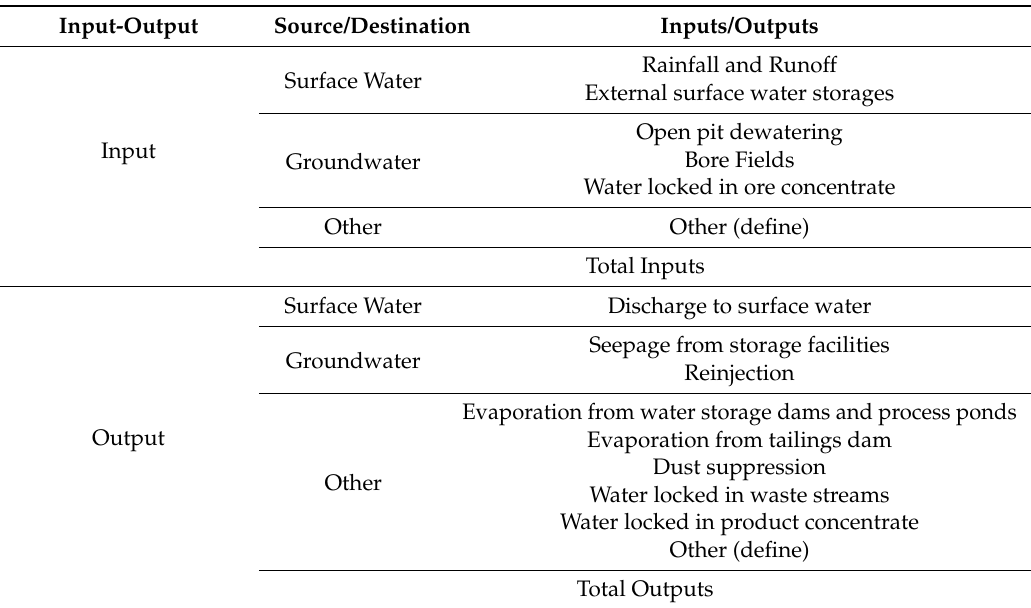
Figure 1. Visual representation of a mine site water system used to conduct water balance and accounting training, based on [40] and [17]. Table 2. Sample template for companies participating in the South Gobi Water and Mining Industry Roundtable in Mongolia to report water inputs and outputs